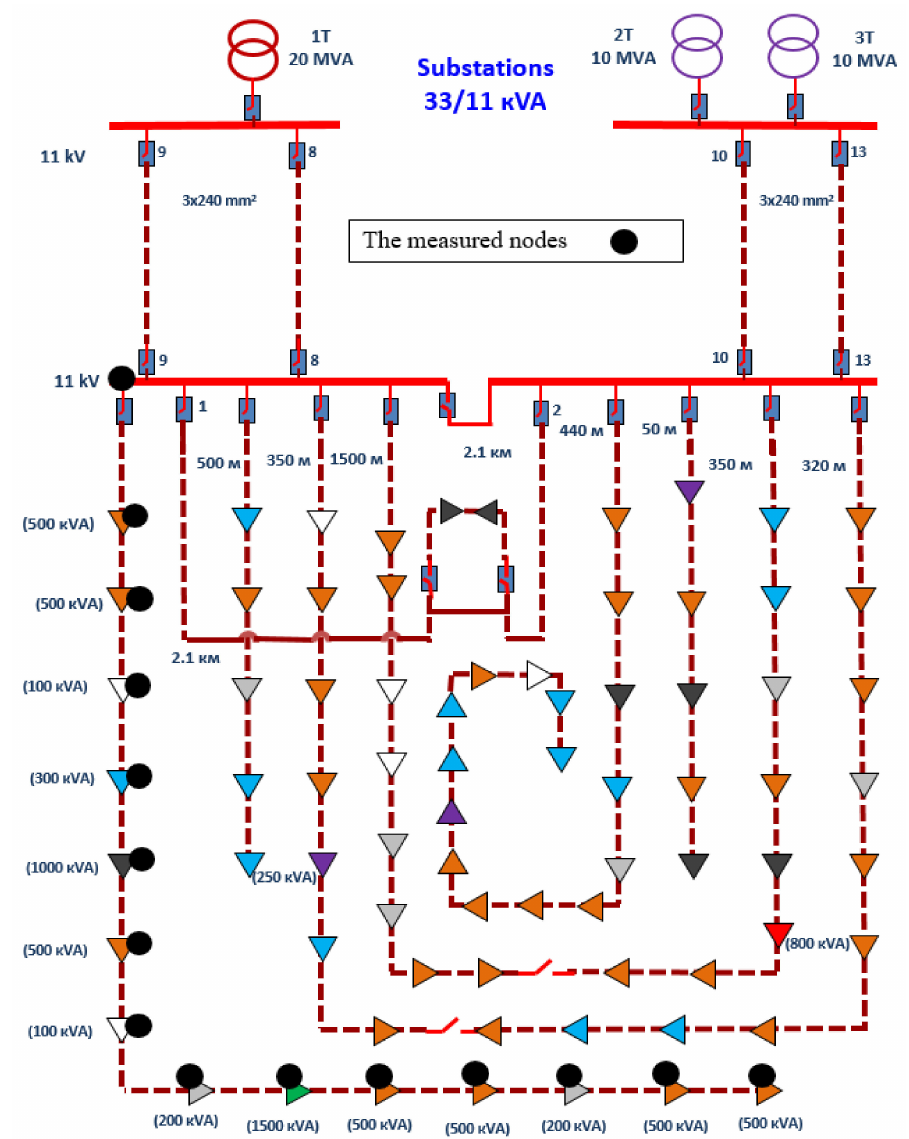
Figure 2. The measured case study of the Middle Egypt Distribution Network (MEDN) at the nodes with black circle.